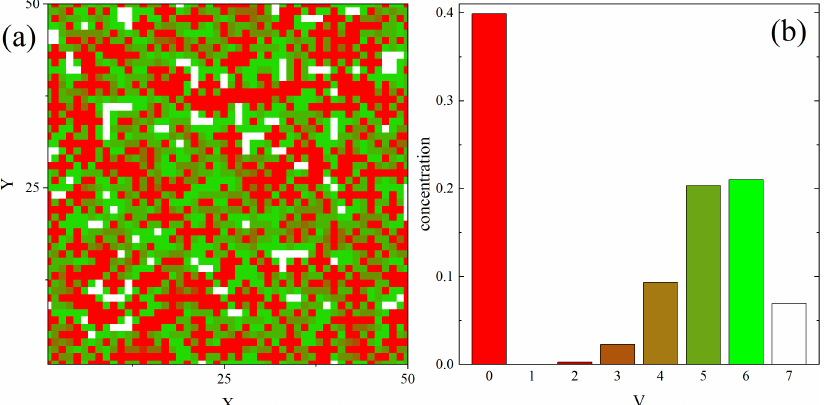
Figure 6. ( a ) Map V ( (cid:126) r ) of mosaic-like free volume configurations of the matrix, see text for more details. ( b ) Probability distribution (empirical histogram) ρ ( V ) of local void parameter V . T = 0.25. Based on